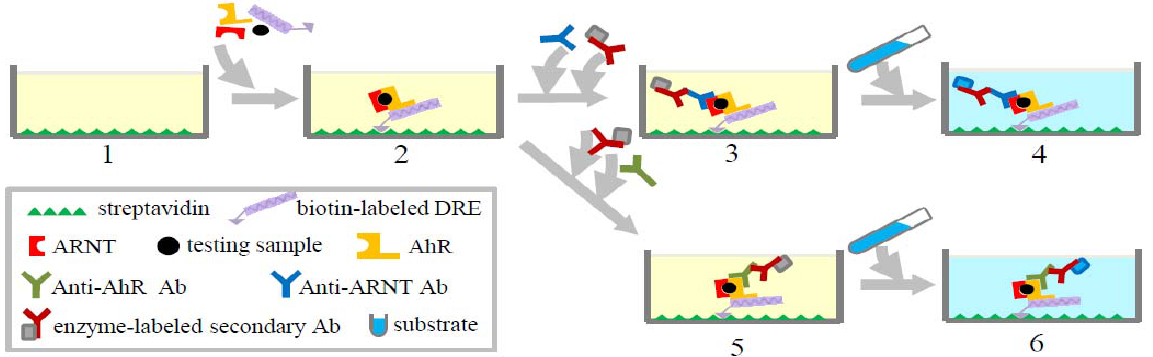
Figure 2. Schematic diagram for experimental procedures of Ah-I for detecting dioxins. Microplates are coated with streptavidin (1). Cell lysate containing AhR and ARNT, testing samples containing dioxins, and biotin-labeled DNA fragments containing DRE consensus sequences are added into the microplate. Biotin-labeled DRE binds to streptavidin. AhR activated by dioxins combines with ARNT to form a complex, which is immobilized by binding to DRE (2). Anti-ARNT antibody (3) or anti-AhR antibody (5) is added to recognize the complex. Secondary antibodies and substrates are added for detection (3, 4, 5,